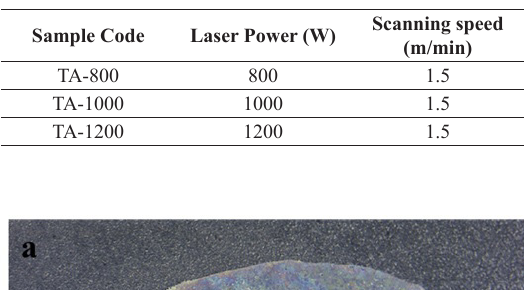
Table 1. Sample codes and laser processing